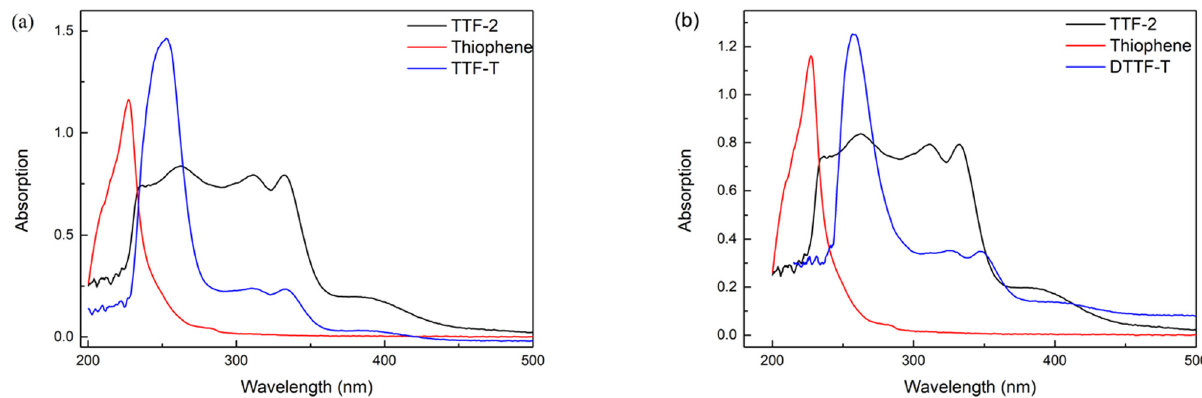
Figure 4: UV - Vis spectra: ( a ) TTF - 2, TTF - Th, and thiophene; ( b ) TTF - 2, DTTF - Th, and thiophene.